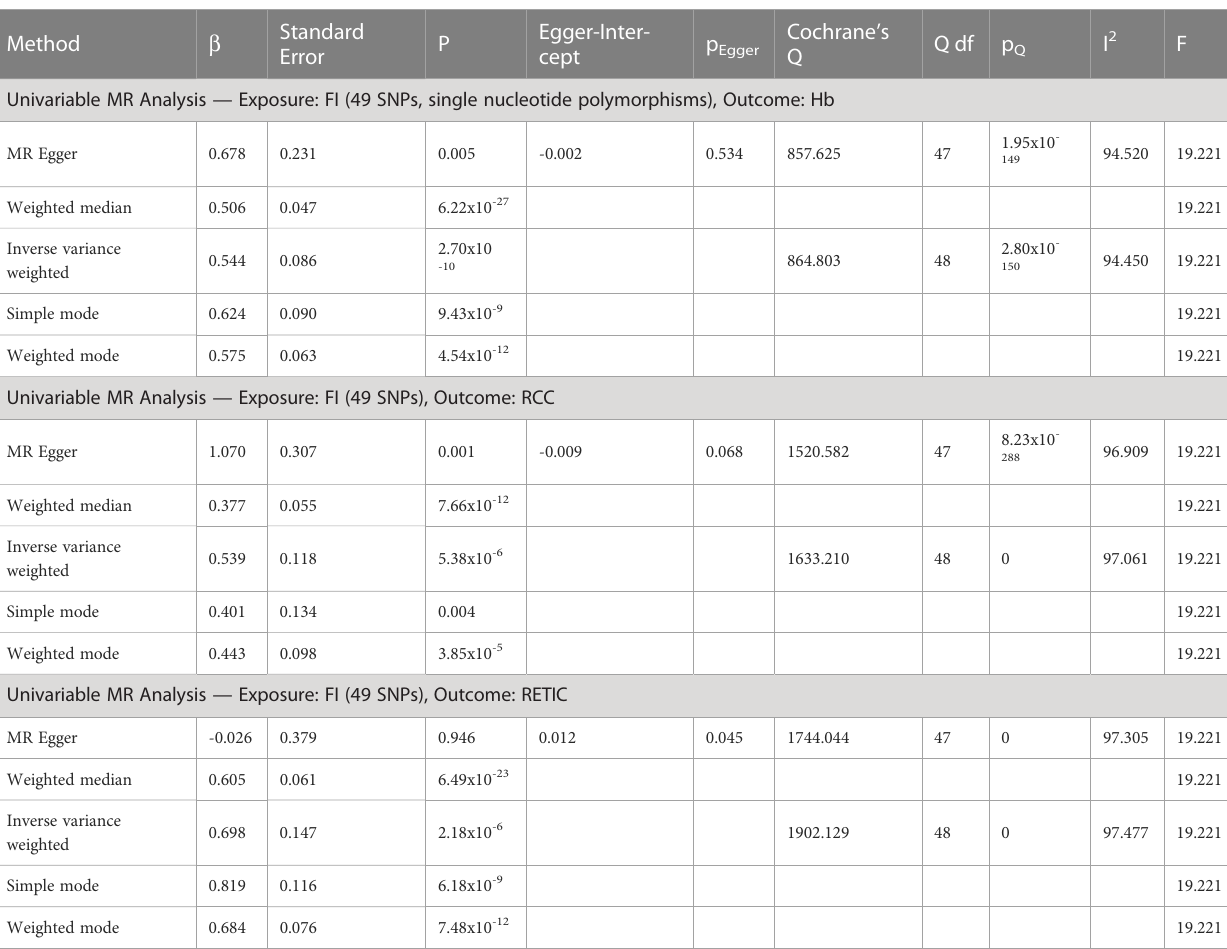
TABLE 3 Univariable MR analyses of fasting insulin (FI) as exposure and hemoglobin (Hb), red cell count (RCC) and reticulocyte count (RETIC) as